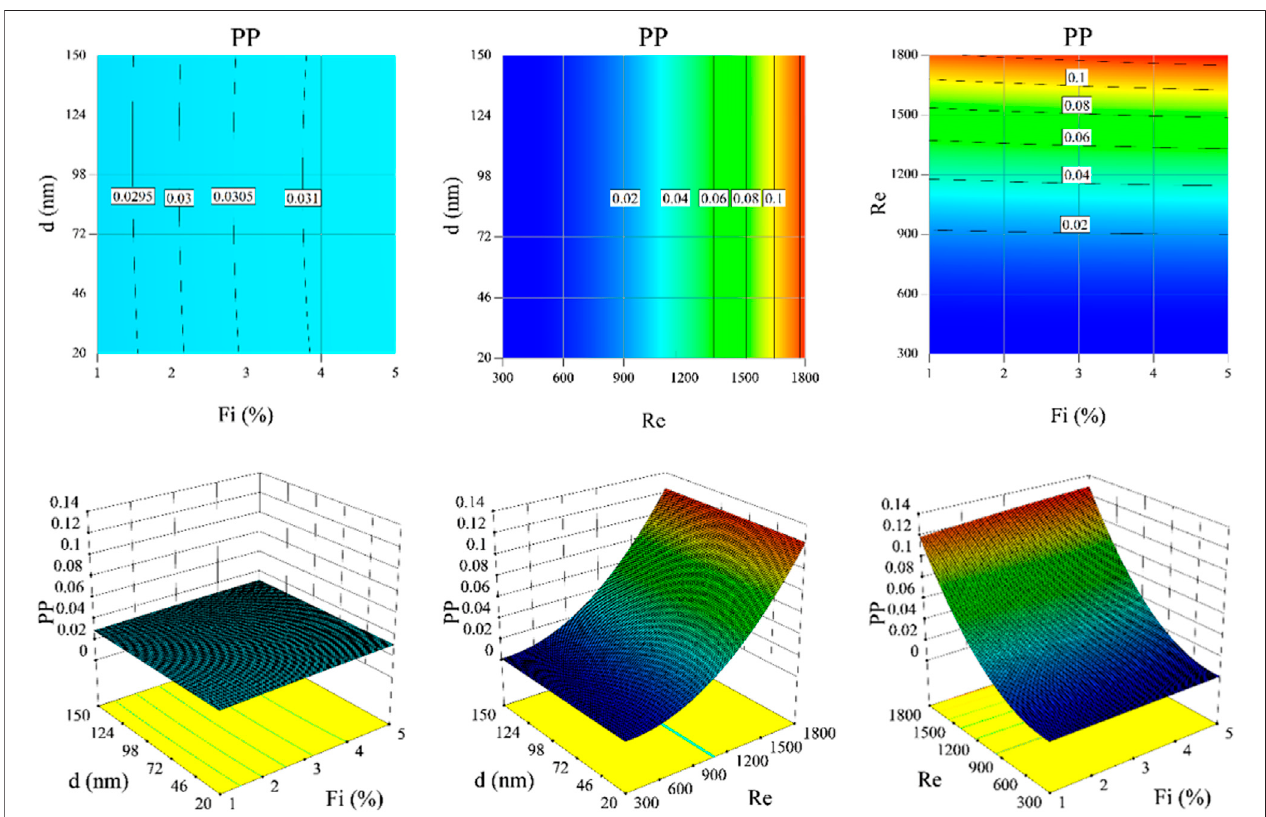
FIGURE 6 | PP required to fl ow the fl uid for dissimilar values of Re , d , and Fi .